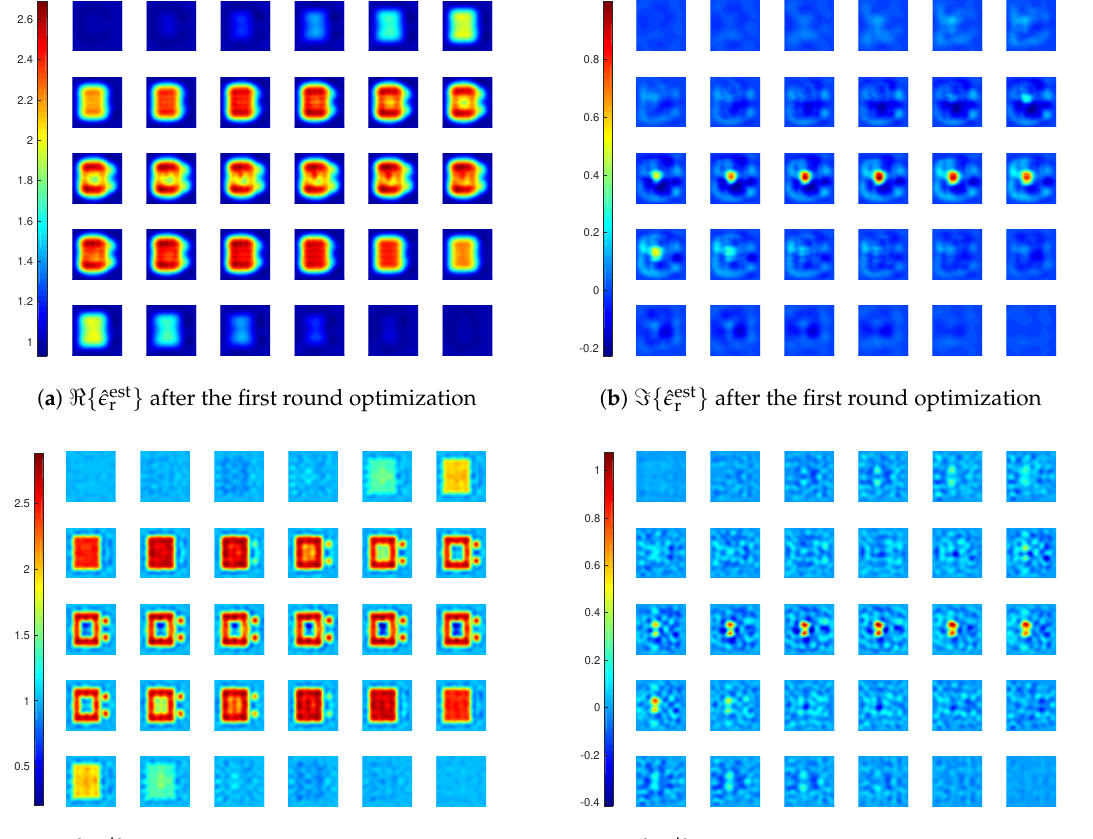
Figure 14. Reconstruction results of inversions with CIE-I for Example 3 . In the first round, β 1 = β 2 = 6. In the second round, β 1 = β 2 =